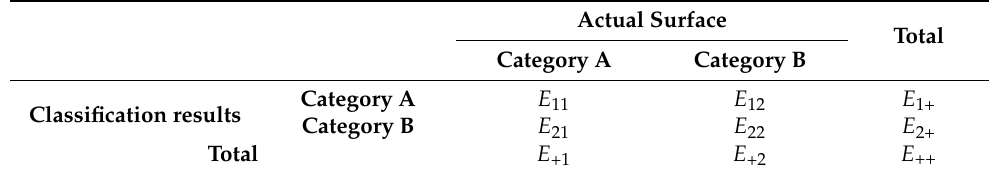
Table 1. Example of error matrix.